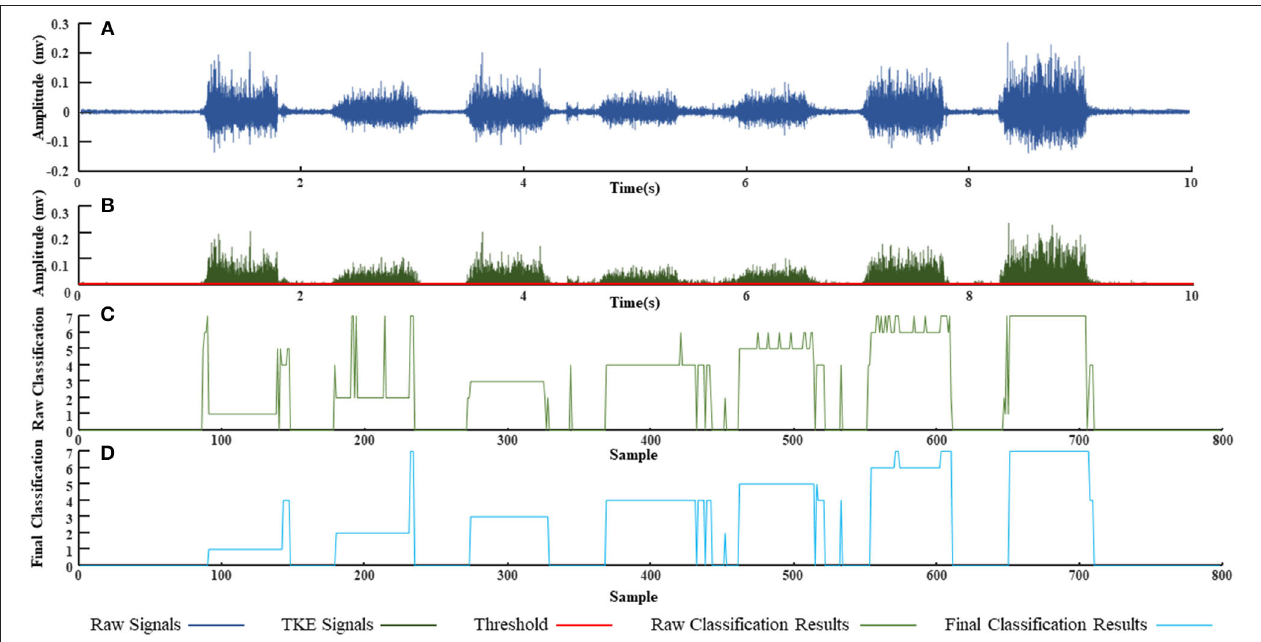
FIGURE 10 | Real-time hand gesture recognition from a representative subject (H4). (A) The raw surface electromyography (sEMG) signals recorded from the left brachioradialis (BRA); (B) the Teager Kaiser energy (TKE) signals extracted from (A) with a threshold 0.001mv; (C) the raw classification based on the SVM; (D) final classification based on the TKE and the three consecutive judgment